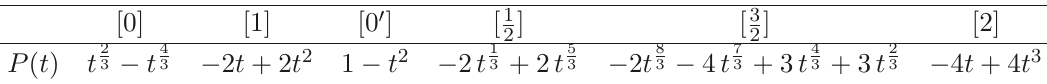
Table 7 . Numerators P ( t ) of the single particle indices i( β ) =